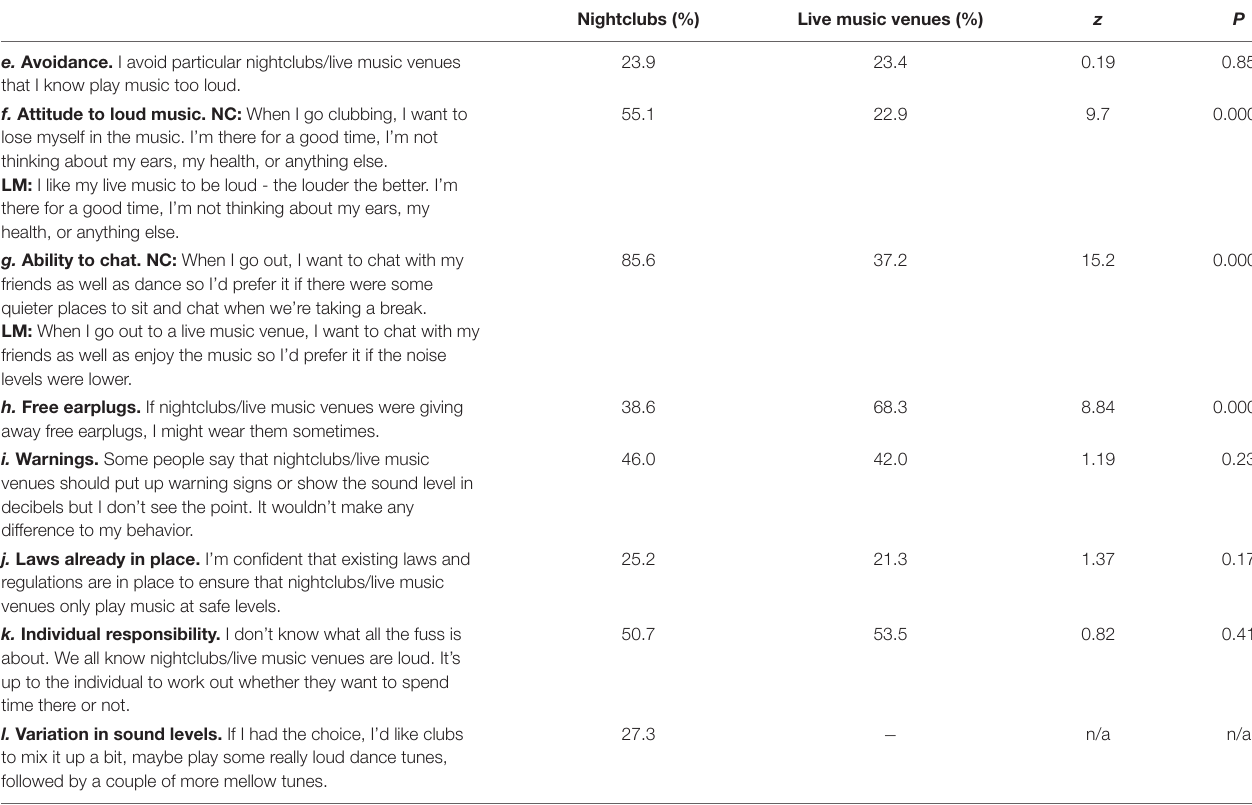
TABLE 2 | Percentages of participants who “agree/strongly agree” with statements in items e–l and results of two-proportion z -tests. Nightclubs (%) Live music venues (%) z